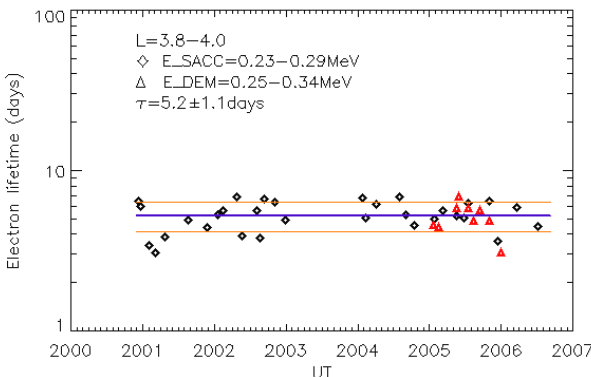
Fig. 2. Electron lifetimes as deduced from the SAC C (black dia- monds) and DEMETER (red triangles) satellite data, as a function of time of measurement for a given indicated position. The blue continuous line corresponds to the mean lifetime value (5.2 days) that results as an average over all measured values. The orange lines indicate the standard deviation to the mean value.